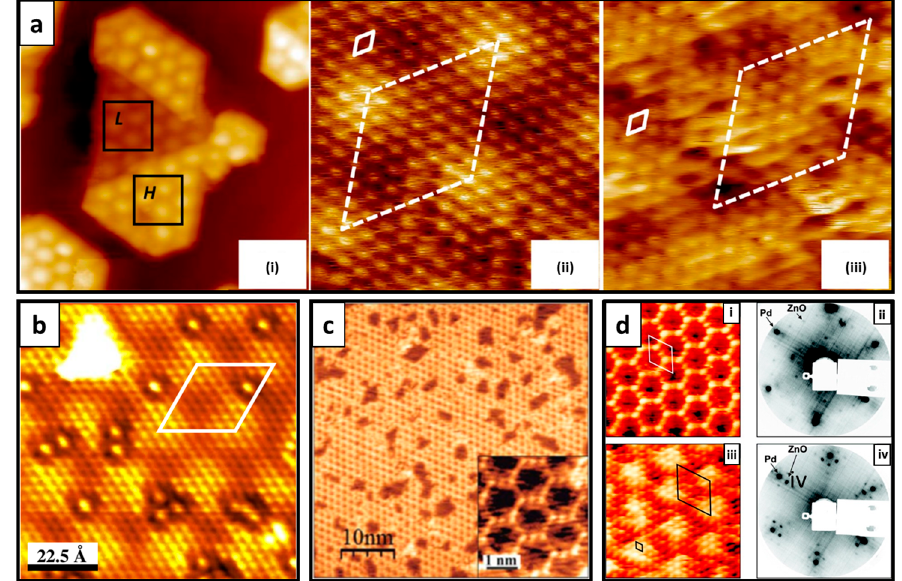
Figure 3. g-ZnO growth over metal substrate (e.g., Au, Ag, Pt, Pd). ( a ) High resolution STM images displaying (i) of both low- and high-layer g-ZnO structures grown over Au(111) (30 × 30 nm 2 ) (ii and iii) atomic structure of low- and high-ZnO (5 × 5 nm 2 ), respectively. The white solid and the dashed lozenges in panels (ii) and (iii) indicate, respectively, the repeating unit of g-ZnO ( ∼ 3.3 Å) and the Moiré pattern ( ∼ 23 Å). Reprinted with permission from Reference [20]. Copyright © (2013) American Chemical Society; ( b ) Atomic resolution STM image of the 2.2 mono-layers grown over Ag(111) (9 × 9 nm 2 ). Reprinted with permission from Reference [4]. Copyright © (2007) American Physical Society; ( c ) Room-temperature STM image of g-ZnO layers grown over Pt(111) surface and atomic resolution image (inset) of the (4 × 4) structure. Reprinted with permission from Reference [18]. Copyright © (2014) American Chemical Society; ( d ) Atomic resolution STM images showing (i): the (4 × 4) phase (65 Å × 65 Å) of g-ZnO grown over Pd(111), (ii): the corresponding (4 × 4) LEED pattern; (iii): high resolution STM image of the (6 × 6) phase (50 Å × 50 Å), and (iv): the corresponding (6 × 6) LEED pattern. (For a (4 × 4) phase four Pt(111) surface unit cells coincide with four g-ZnO cells and for a (6 × 6) phase six Pt(111) surface unit cells coincide with six g-ZnO cells). Reprinted with permission from Reference [17]. Copyright © (2010) American Chemical Society.